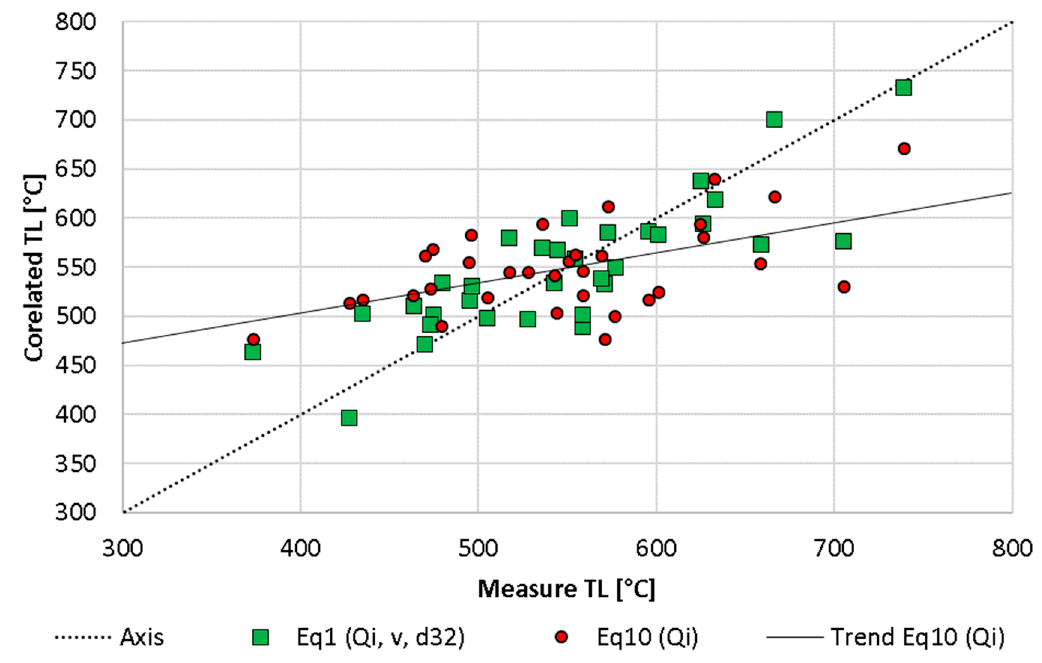
Figure 10. Correlation between measured T L and calculated T L for three selected equations